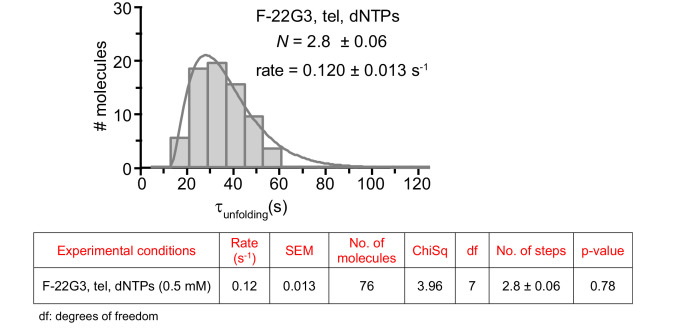
The unfolding rate of F-22G3, calculated by fitting the dwell time distributions of the intermediate FRET state (see Figure 2G) to a gamma distribution (n = 76 molecules).N represents the number of kinetic steps in the best-fitting equation; fitting parameters (Chi-square and associated p-value) are shown in the table.